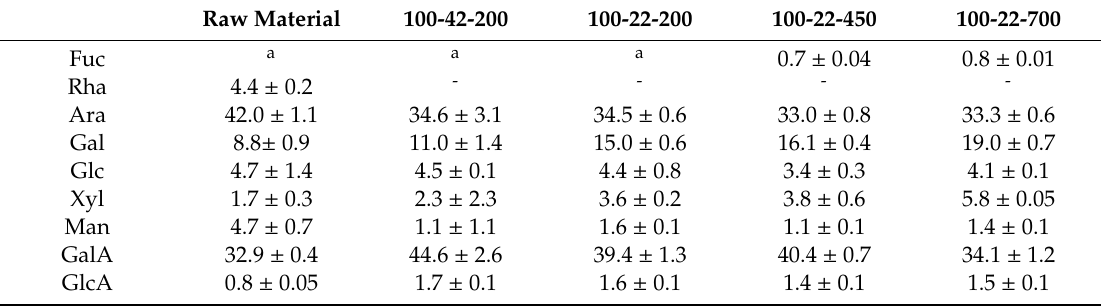
Table 3. Monosaccharide composition (mol%) of soluble dietary fiber of raw and extruded apple pomace after methanolysis (mean value ± range / 2, n = 2) Fuc: fucose, Rha: rhamnose, Ara: arabinose, Gal: galactose, Glc: glucose, Xyl: xylose, Man: mannose, GlcA: glucuronic acid, GalA: galacturonic acid. Raw